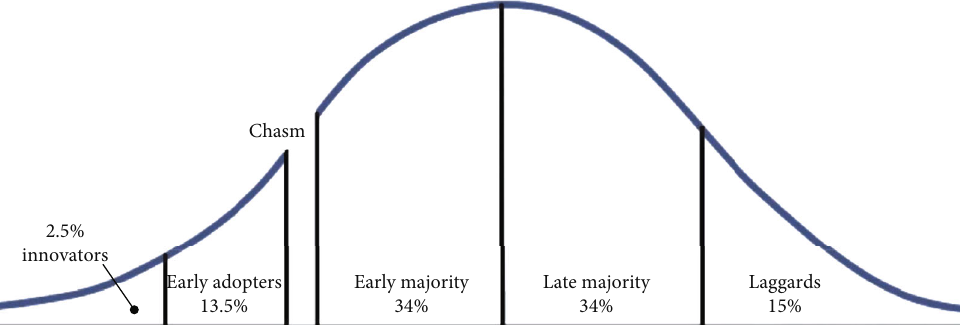
Figure 9: Innovation adoption curve [3].